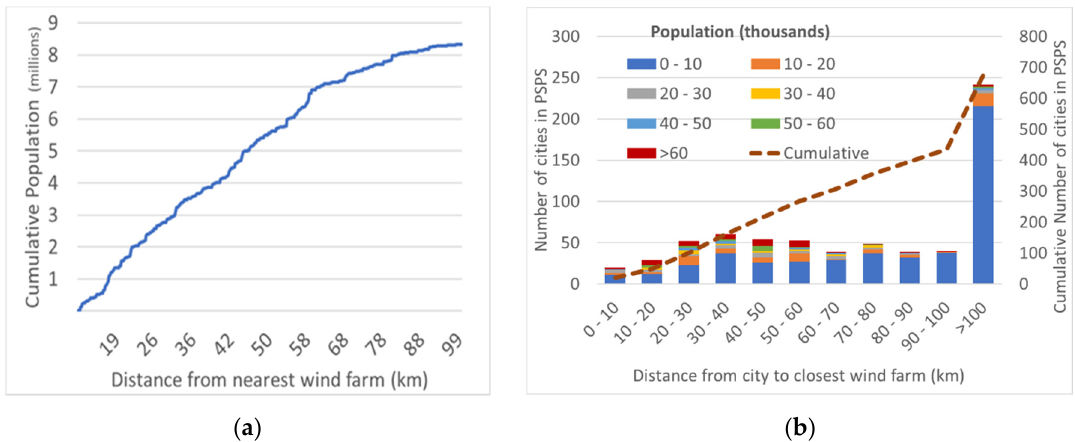
Figure 7. Distance from closest wind farms for PSPS cities considering ( a ) cumulative population ( b ) number of cities classified by population.